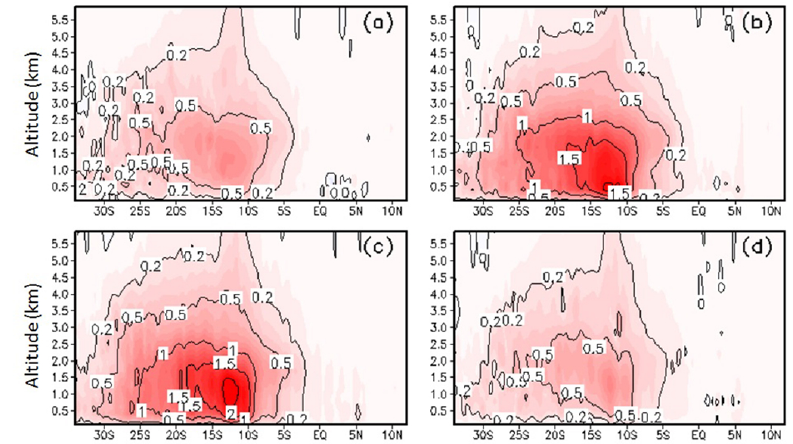
Fig. 12. North-South cross section (red line Fig. 10) average profile of the differences (Kday − 1 ) between modeled net radiative heat- ing/cooling rates including and excluding the aerosol direct radiative effect over the biomass burning season at (a) 12:00UTC, (b) 15:00UTC, (c) 18:00UTC and (d)